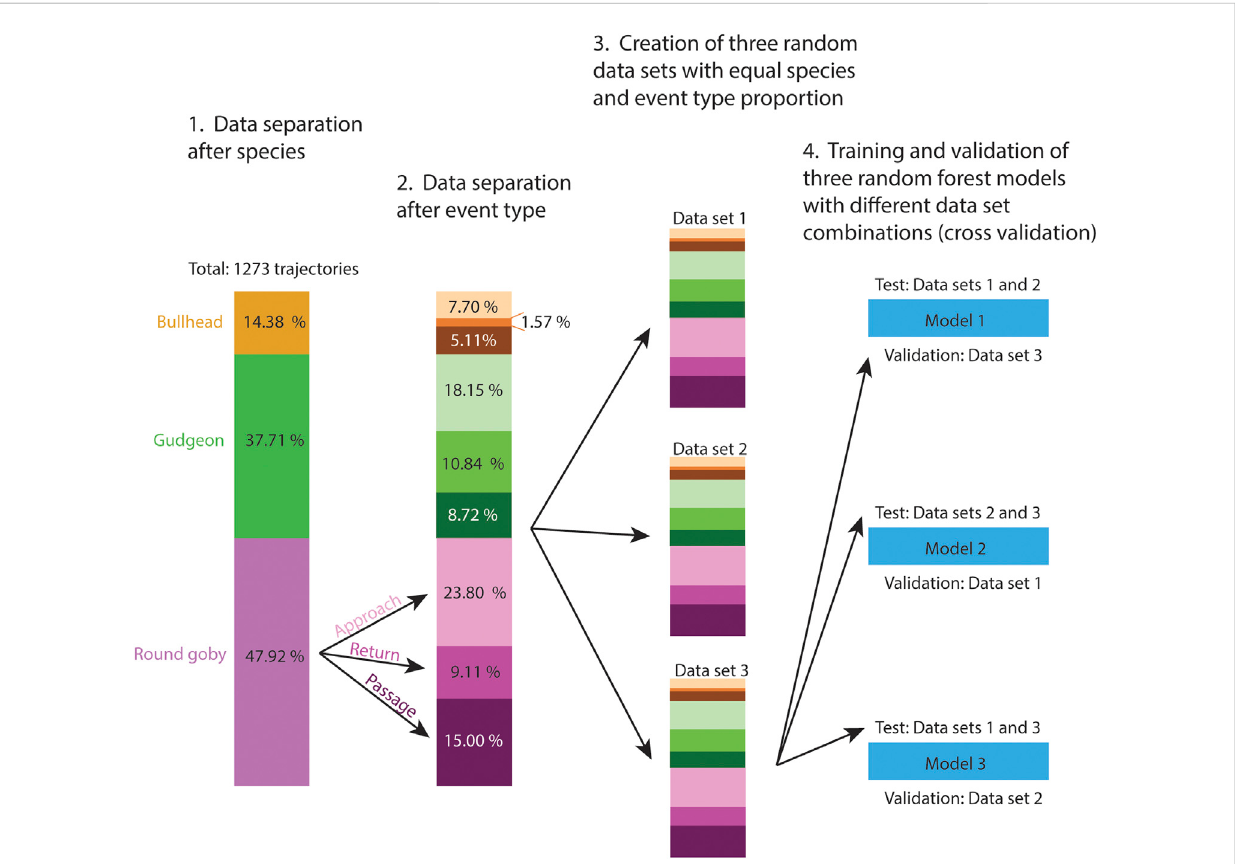
FIGURE 1 Pre-processing (1. – 3.) of the trajectory features data set prior cross validation of the random forest model (4.). Three data sets of similar size were created for cross validation. Because we recorded different amounts of trajectories per fi sh species and event types, we distributed the trajectories of these categories with equal proportion between data sets to ensure the categories were represented in the training data as well as in the validation data